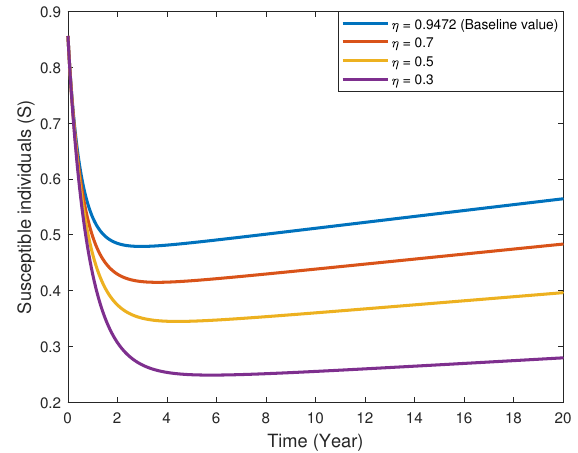
Figure 19. Behavior of S class for different η